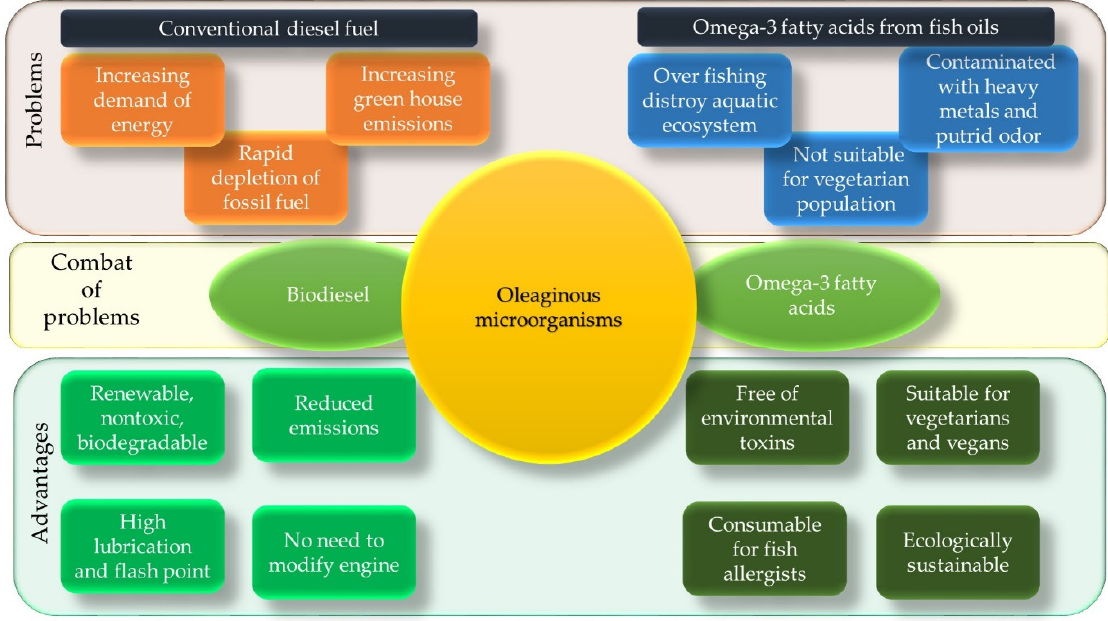
Figure 2. Role of oleaginous microorganisms to combat the problems of greenhouse gas emissions and improving air quality by using biodiesel in vehicles; likewise production of polyunsaturated fatty acids to fulfill the ever-rising global demand of omega-3 fatty acids and replace the use of fish oil that have become a persistent problem for the global aquatic ecosystem.